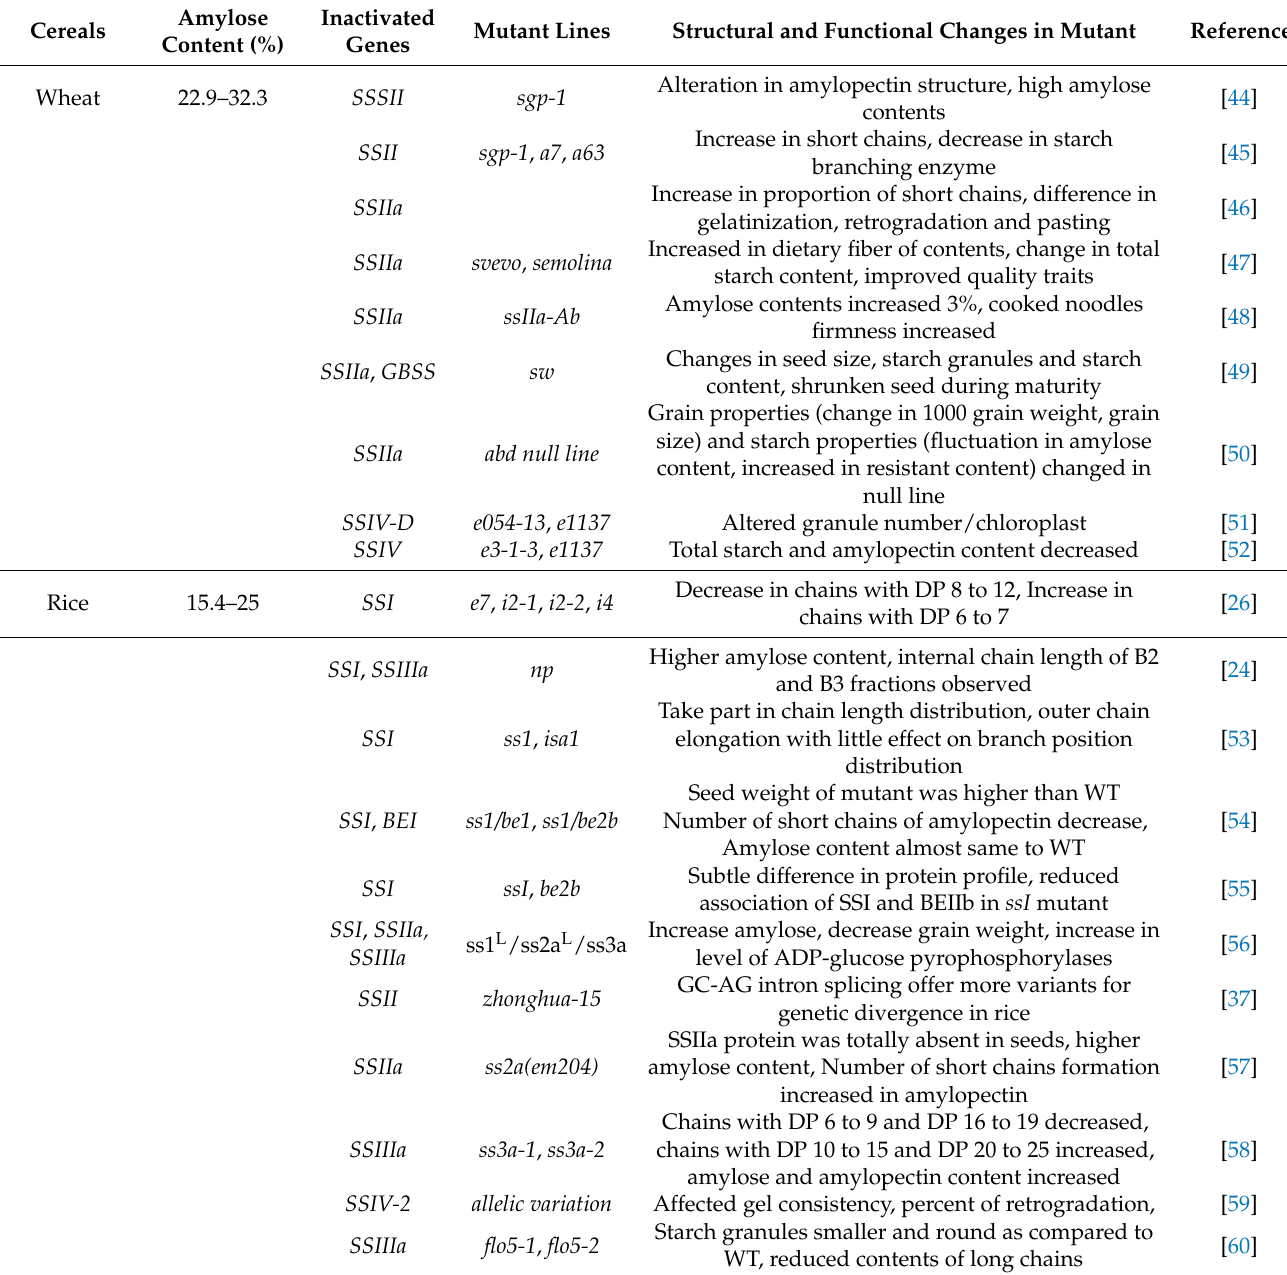
Table 2. Mutation effect on starch synthase genes in different cereal